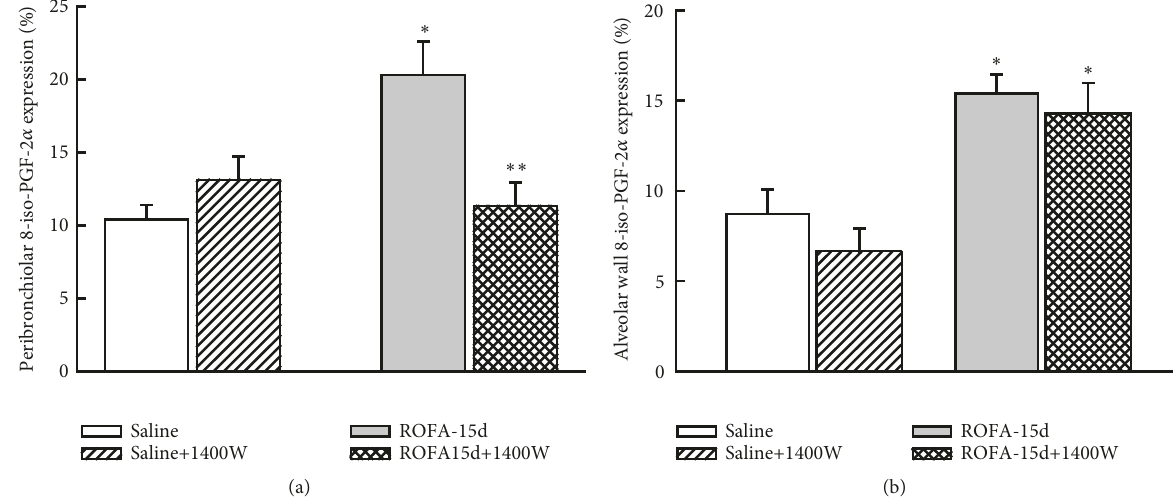
Figure 3: Oxidative stress: this figure represents the mean and SEM values of 8-iso-PGF-2a expression (%) in peribronchiolar and alveolar wall. The ROFA instillations increased the positive area and the iNOS inhibition reduced it only around bronchioles. ∗ p < 0.05 compared with saline groups; ∗∗ p < 0.05 compared with animals that received ROFA and vehicle